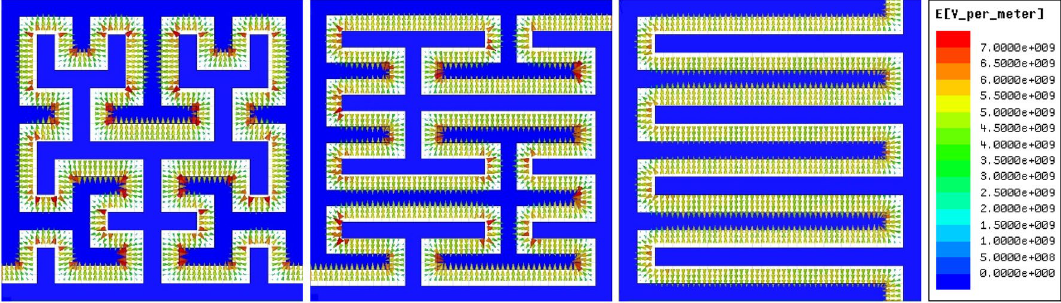
Figure 1. Simulation results of electric field intensity between sensor electrodes: ( a ) Hilbert–Piano curve a; ( b ) Hilbert–Piano curve b; ( c ) Interdigitated electrodes.